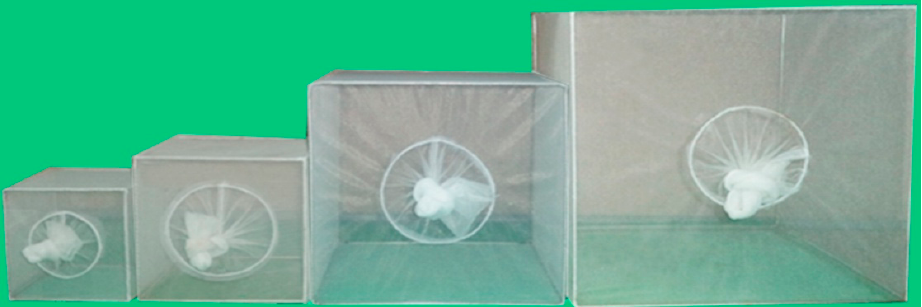
Figure 1. Four cages (left to right: 10, 20, 30 and 40 cubic cm cages) used for self-mating mosquitoes. The mean insemination rate was calculated from dissection of a total of 200 spermathecae (duplicate experiments, 100 spermathecae/experiment), and examined for evidence of insemination